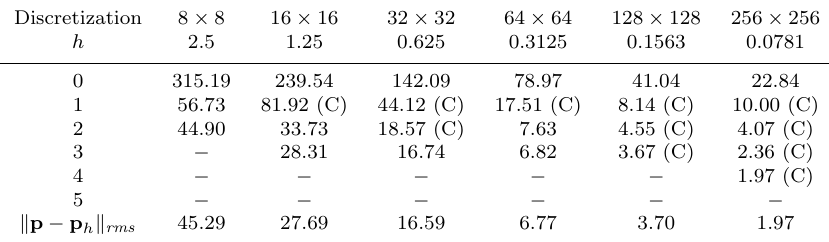
Table 4. Hertzian contact: The norm (cid:107) p − p FMG (cid:107) rms . The first column is the number of h iterations, where 0 indicates the initial error. h = max( h x ,h y ) is the maximum mesh size. “(C)” means that after this iteration, the contact area is modified, and “ − ” means that the numerical error does not change. The V(1,1)-cycle is used in FMG.